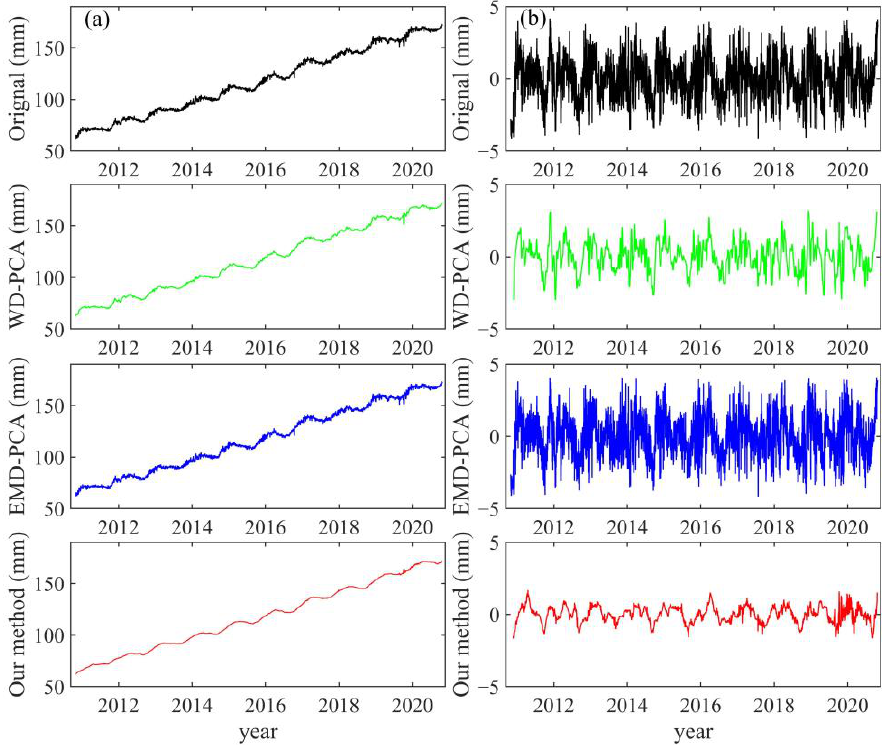
Figure 5. ( a ) Raw and denoised GNSS coordinate time series in N direction of site P242, and ( b ) their corresponding residual time series. (Black lines: raw time series; green lines: resuls via WD-PCA; blue lines: resuls via EMD-PCA; red lines: resuls via the propsed method).